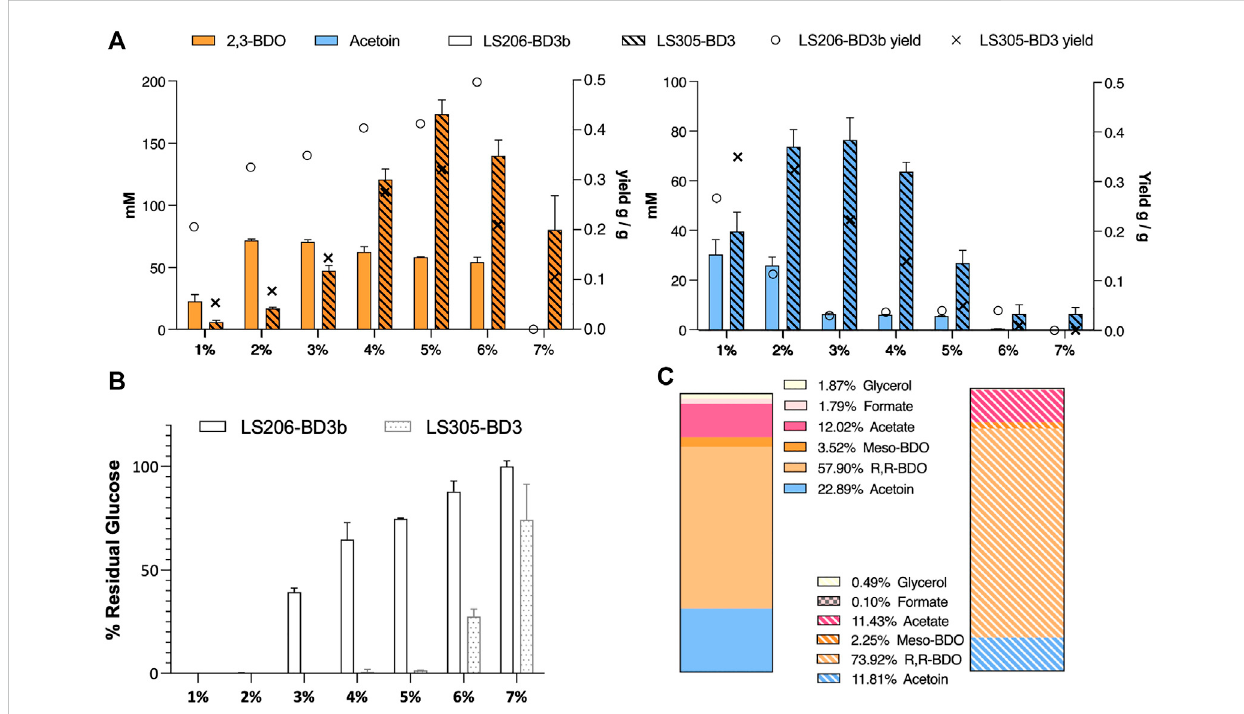
The effect of glucose concentration on acetoin and 2,3-BDO production. (A) Acetoin and 2,3-BDO levels under different glucose concentrations. Yield (right Y-axis) is gram of product produced per gram of glucose consumed. 2,3-BDO yields increase while acetoin yields decrease with higher glucose concentrations. More glucose was consumed under more aerated condition (2 mL fermentation volume, strain LS305 habouring pMTL-BD3), and less under oxygen limitation (6 mL fermentation volume, LS206 habouring pMTL-BD3b) (B) At 7% glucose and above, cells became unviable. Error bars represent the standard deviation of three biological replicates. (C) Percentage product pro fi les of strain LS206 [pMTL-BD3b] grown at 50 ° C for 48 h, with shaking (250 rpm),in 6 mL M-ASYE with 2%(w/v)glucose(plain) and LS305 [pMTL-BD3] in2 mL M-ASYE with 5%(w/v) glucose